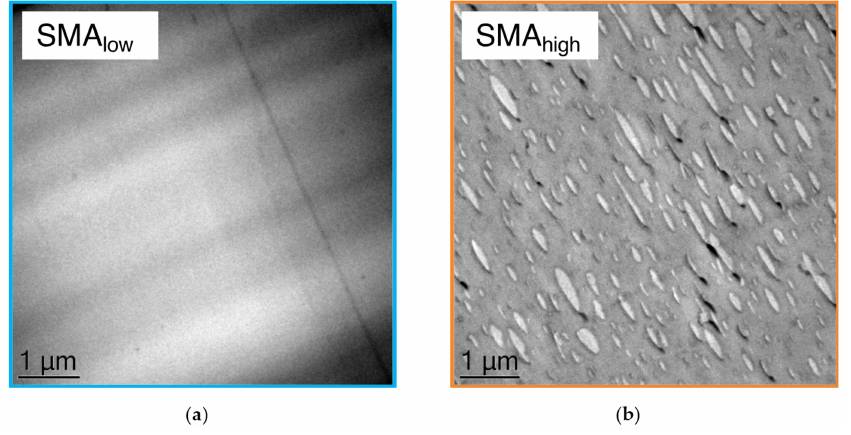
Figure 2. TEM micrographs of ( a ) PPE / SMA low and ( b ) PPE / SMA high binary blends with ratios of 82 / 18 (w /